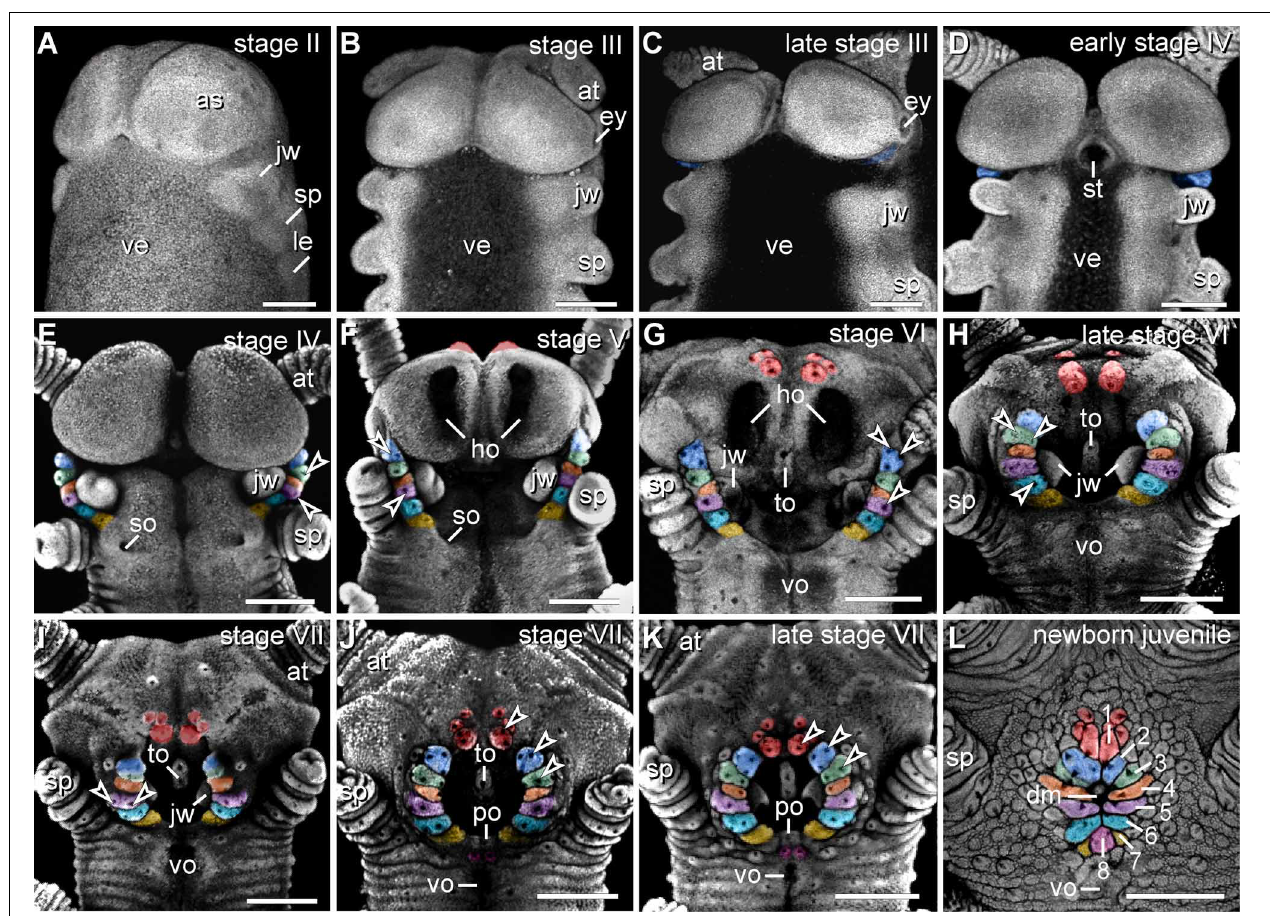
FIGURE 4 | Morphogenesis of lip papillae encompassing the definitive mouth opening in Euperipatoides rowelli . (A–L) Confocal micrographs of embryonic heads at successive developmental stages in ventrolateral and ventral views. DNA labeling with Bisbenzimide. Developing lip papillae are highlighted by artificial colors. Note that the first pair of lip papillae (number 1 in L and red in F–L ) is associated with the first body segment and that it moves from an anterior to a ventral position during development. Note also that the remaining pairs of lip papillae (numbers 2–7 in L ) arise lateral to the anlagen of jaws, i.e., in the second body segment, whereas the posterior-most